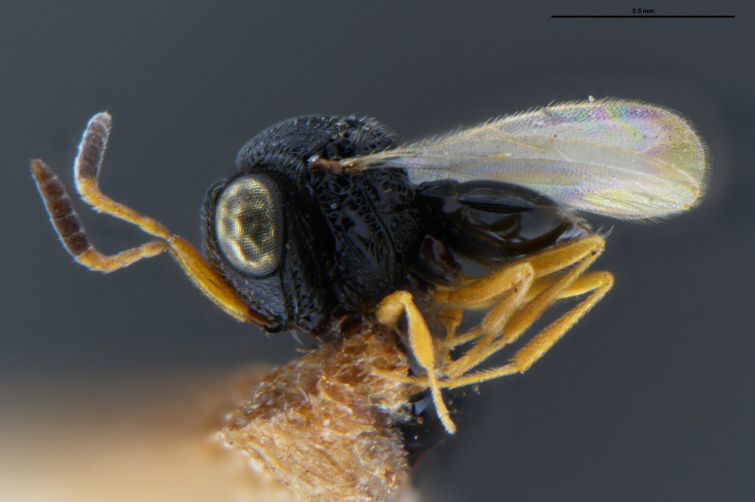
lateral habitus